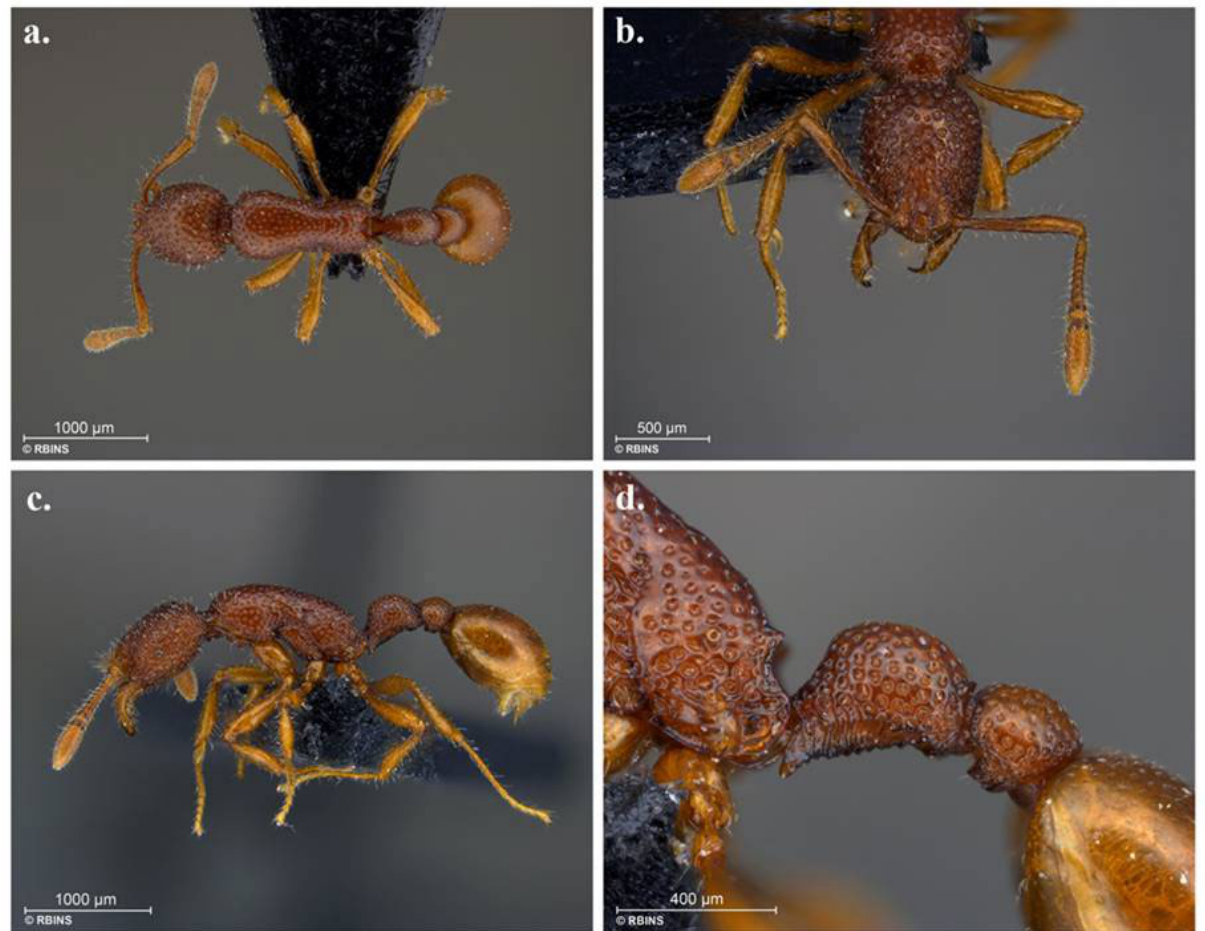
Fig 1 . High resolution pictures of the Tyrannomyrmex rex worker collected in Singapore. Dorsal ( a. ), frontal ( b. ) and lateral ( c. ) views, and a close-up lateral view of the propodeum, petiole and postpetiole ( d.